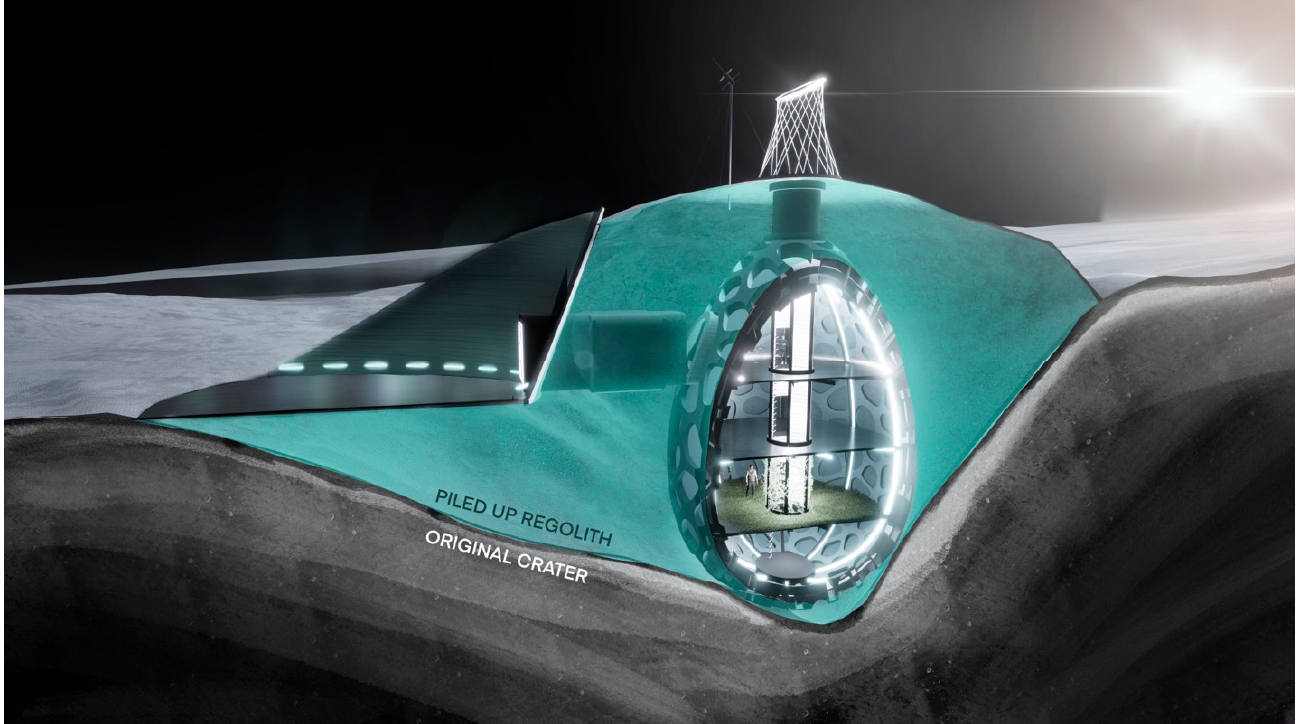
Figure 9. View of the complex with the entrance from the outside.